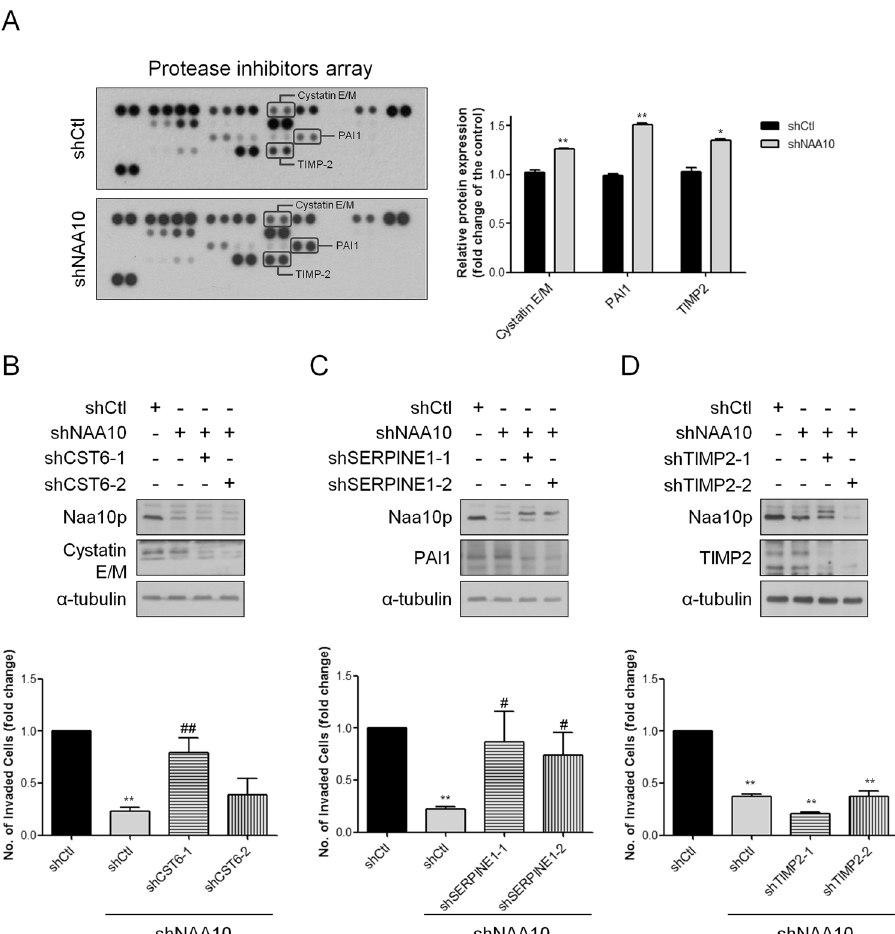
Fig. 7 Naa10p regulates cell invasiveness by inducing protease inhibitor expression. A Protease inhibitor arrays were used to analyze the expression of protease inhibitors in the cell supernatant of KSYE70 transfected with shCtl or sh NAA10 . B Immunoblotting analysis of stably Naa10p-silencing KYSE70 cells transfected with either Ctl-shRNA or CST6 shRNAs. Quantitative data comparing cell invasion of stably Naa10p- silencing KYSE70 cells transfected with either Ctl-shRNA or CST6 shRNAs. Bars are the mean ± SD of three independent experiments. ** P < 0.01 when compared to shCtl group and # P < 0.05 when compared with sh NAA10 -shCtl cells by two-tailed Student ’ s t test. C Immunoblotting analysis of stably Naa10p-silencing KYSE70 cells transfected with either Ctl-shRNA or SERPINE1 shRNAs. Quantitative data comparing cell invasion of stably Naa10p-silencing KYSE70 cells transfected with either Ctl-shRNA or SERPINE1 shRNAs. Bars are the mean ± SD of three independent experiments. ** P < 0.01 when compared to shCtl group and ## P < 0.01 when compared with sh NAA10 -shCtl cells by two-tailed Student ’ s t test. D Immunoblotting analysis of stably Naa10p-silencing KYSE70 cells transfected with either Ctl-shRNA or TIMP2 shRNAs. Quantitative data comparing cell invasion of stably Naa10p-silencing KYSE70 cells transfected with either Ctl-shRNA or TIMP2 shRNAs. Bars are the mean ± SD of three independent experiments. ** P < 0.01 when compared to shCtl group and ## P < 0.01 when compared with sh NAA10 - shCtl cells by two-tailed Student ’ s t